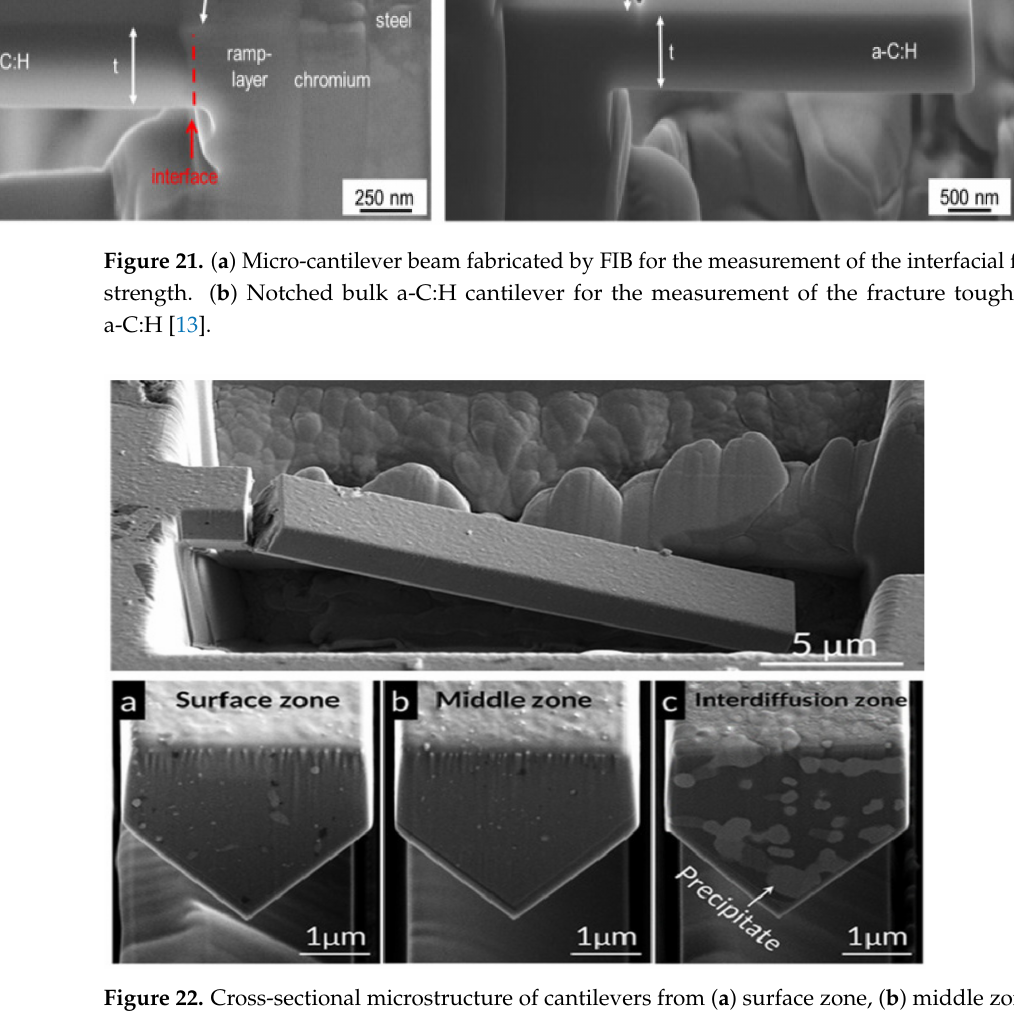
Figure 22. Cross-sectional microstructure of cantilevers from ( a ) surface zone, ( b ) middle zone, and ( c ) interdiffusion zone representing the variation in precipitate content and size between the three zones